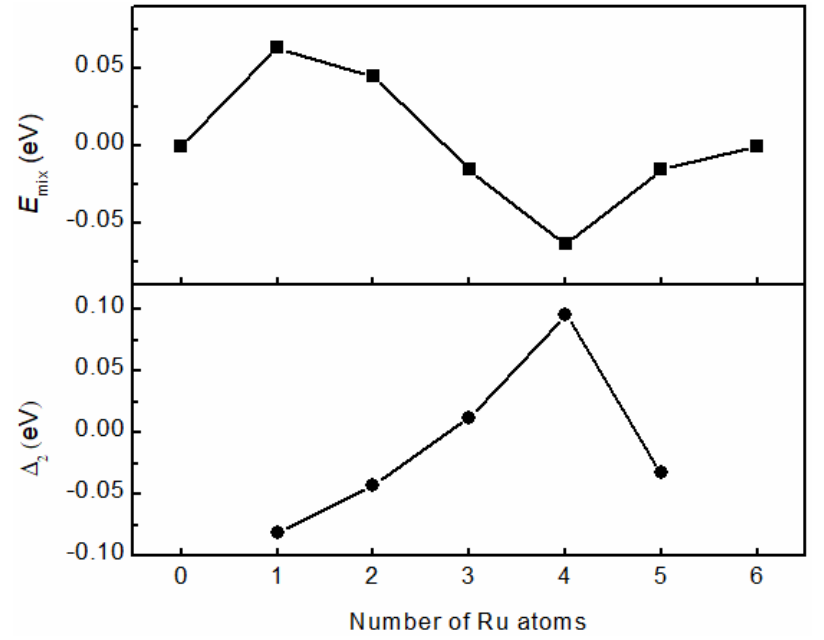
Figure 5. The plot of mixing energy E mix and quadratic difference energy ∆ 2 of octahedral Ru m Rh n clusters varying with the number of Ru atoms. Ru 4 Rh 2 is a magic cluster.